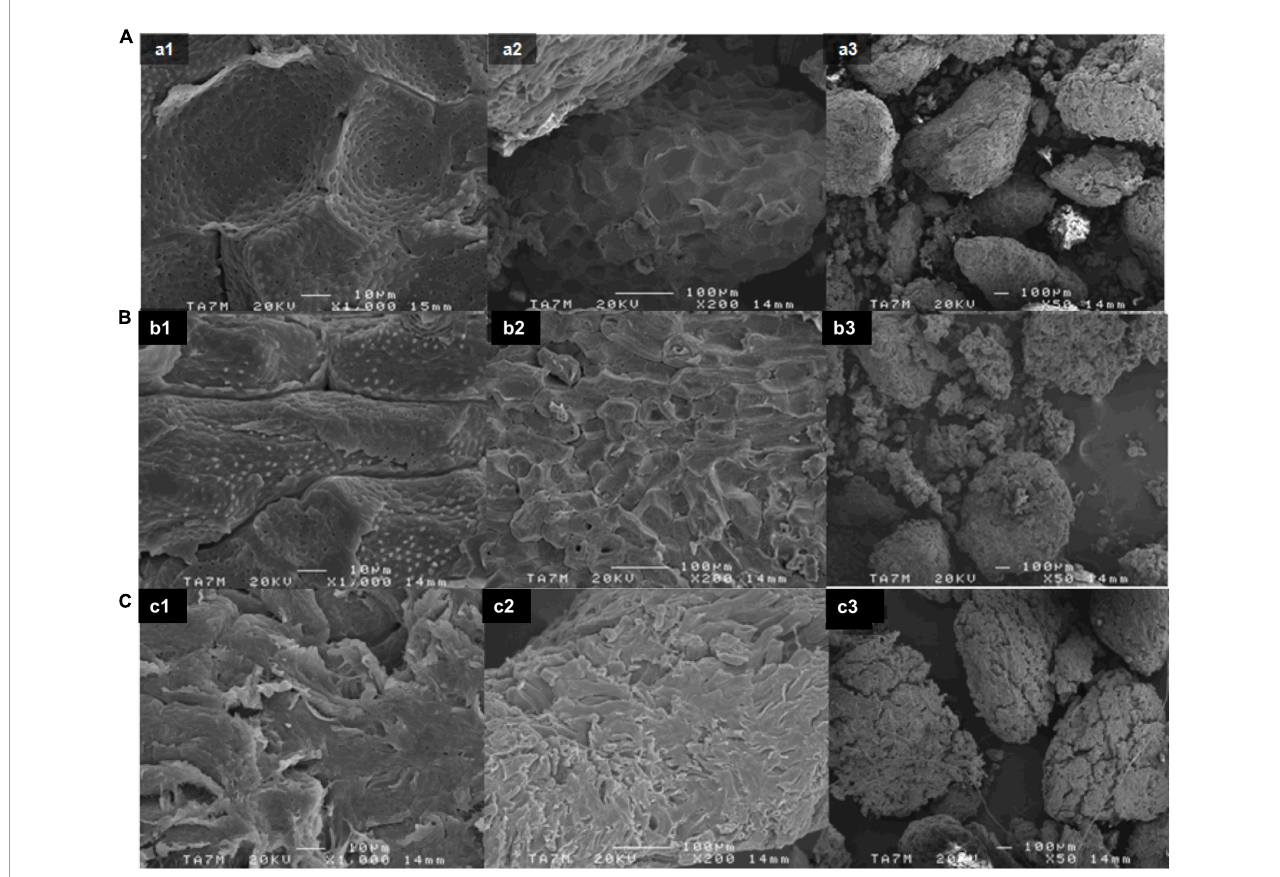
FIGURE1 SEM images of (A) raw AS without any treatment, (B) alkalized AS for 240 min, and (C) alkalized AS for 24 h at (1) 1,000 × , (2) 200 × , and (3) 50 ×